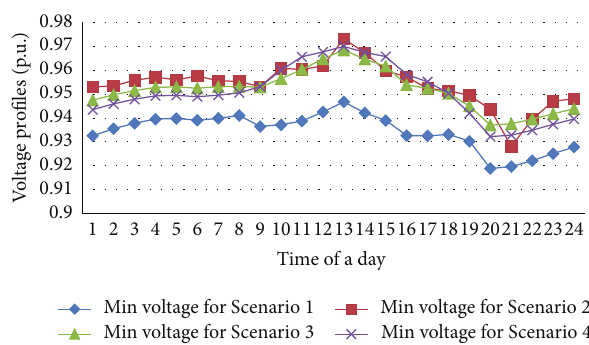
Figure 6: Performance of voltage profile for all scenarios of a